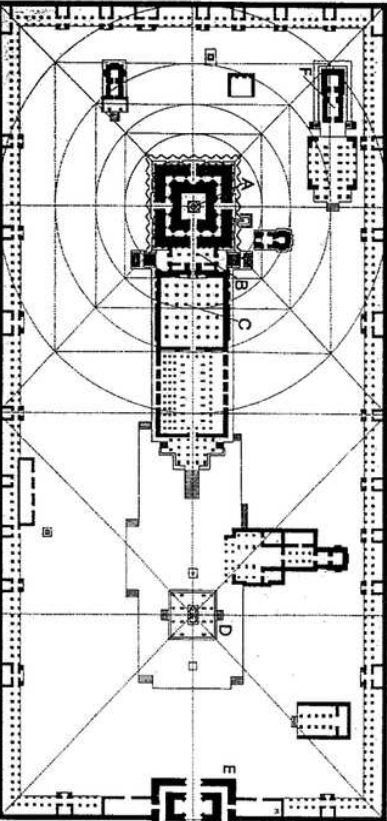
Figure 1. Plan of the Brihadeeshwarar temple